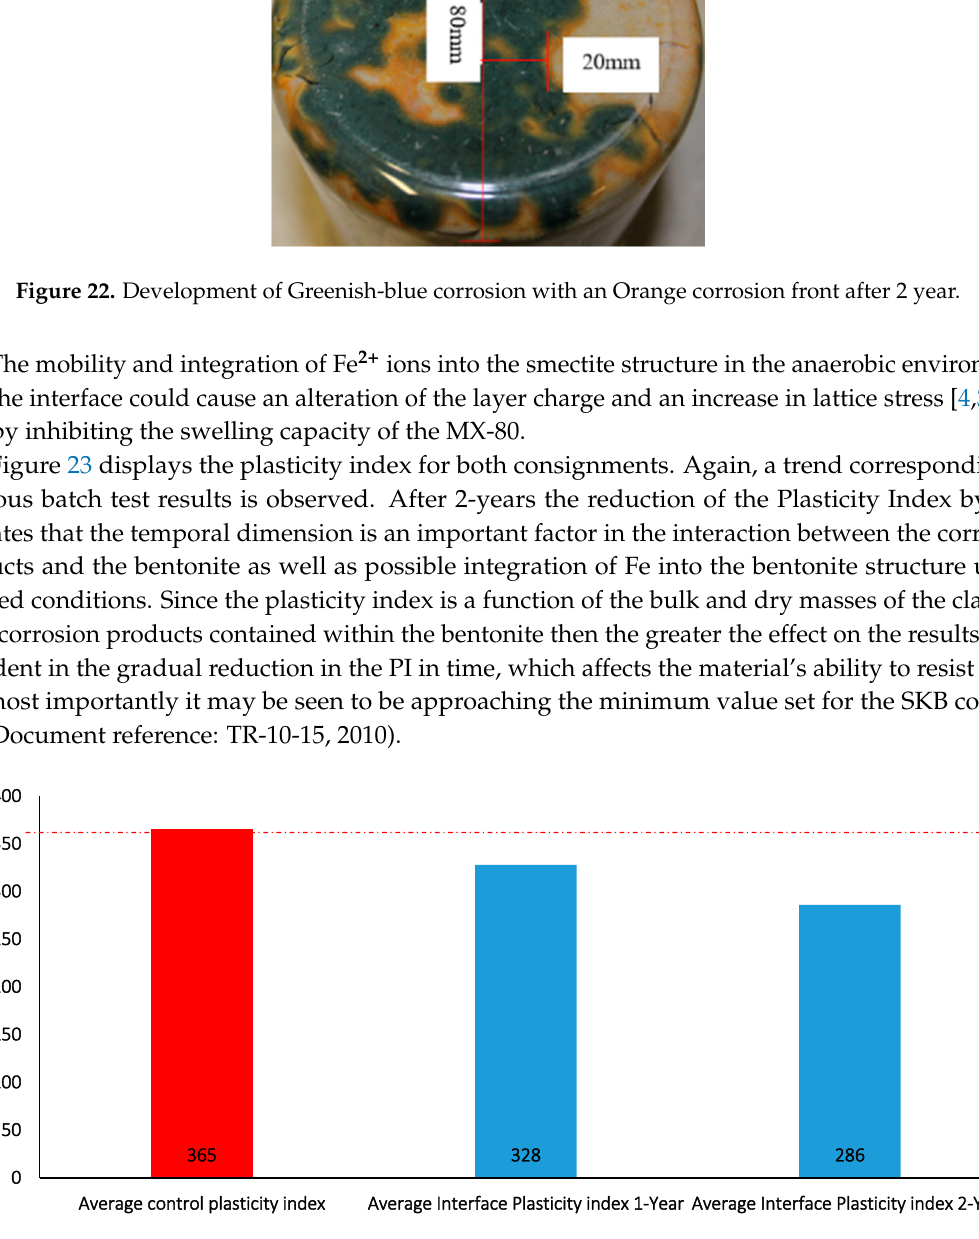
Figure 23. Interface plasticity index for 1 and 2-year batch tests containing DI water only.